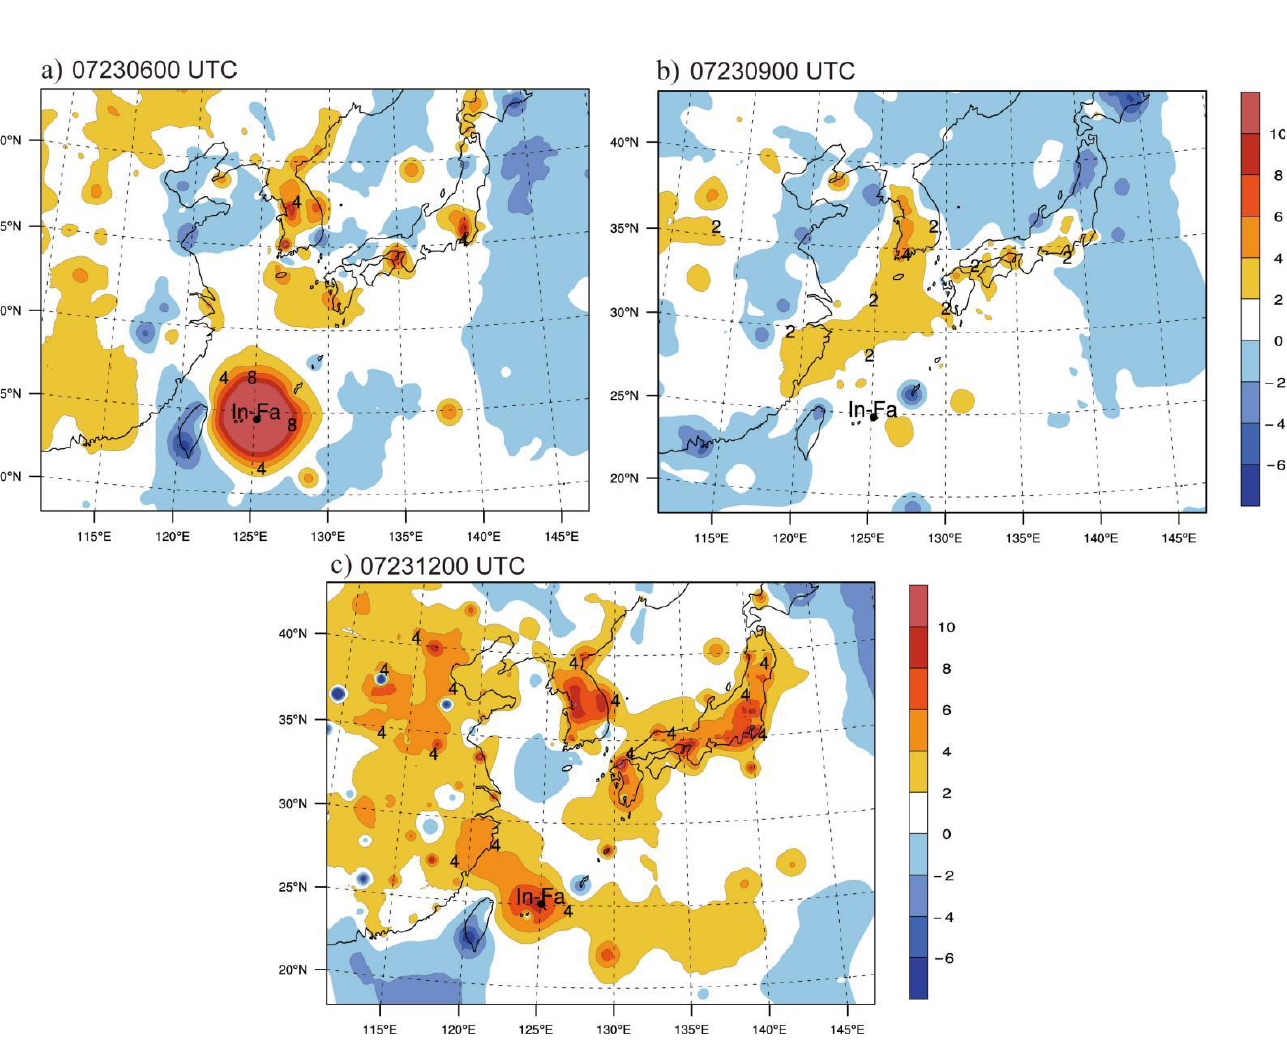
Figure 9. The 500 hPa geopotential height increments (the analysis from the data assimilation minus the background for the data assimilation that is the 12 h spin-up forecast) (shading, units: gpm) in the Cyc experiment valid at ( a ) 0600 UTC 23 July 2021, ( b ) 0900 UTC 23 July 2021, and ( c ) 1200 UTC 23 July 2021. The typhoon center is denoted as the black dot. The numbers show the positive increments of geopotential height.